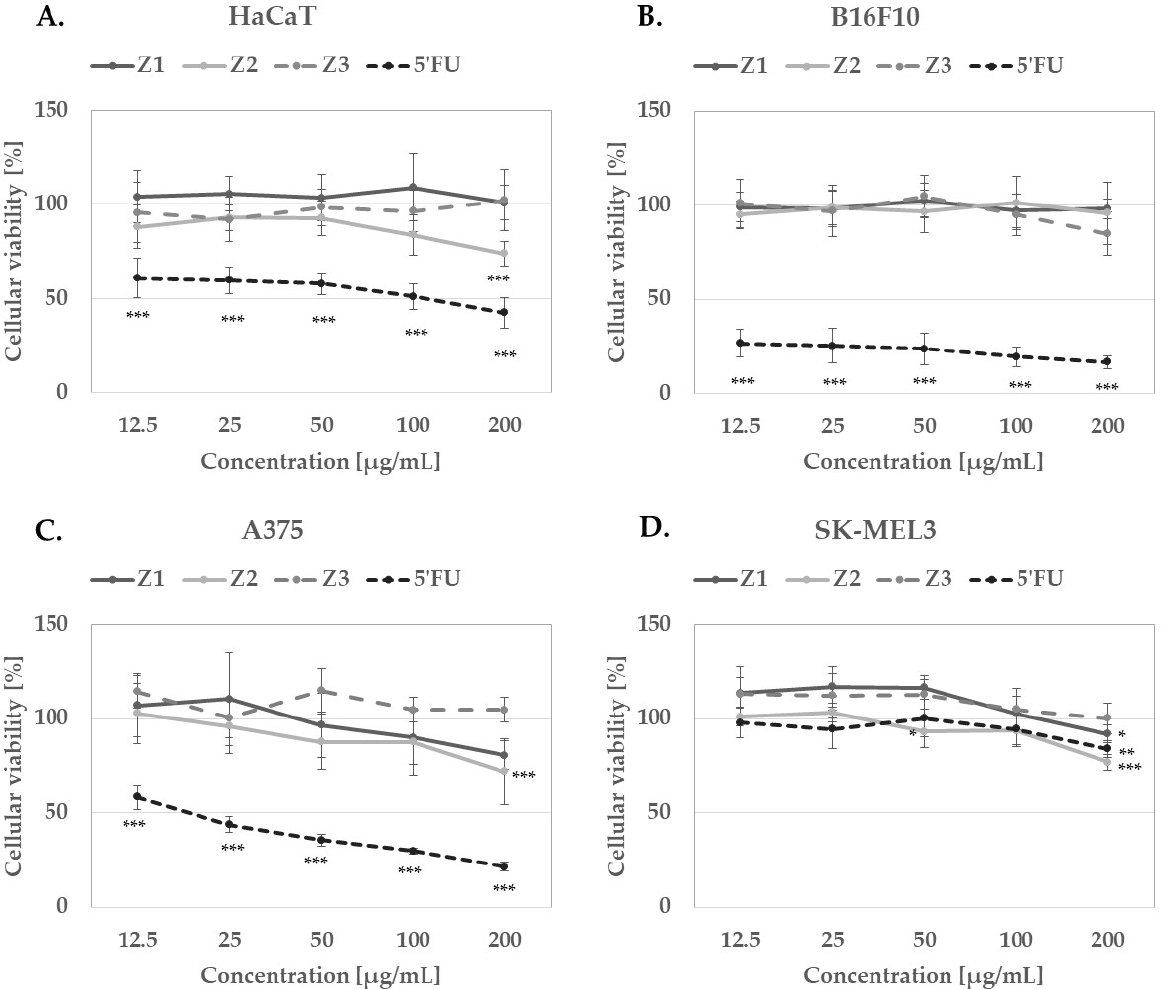
Figure 6. In vitro cytotoxicity of Z1, Z2 and Z3 Z. bungeana extracts on human keratinocytes HaCaT ( A ), murine melanoma B16F10 ( B ) and human melanoma cell lines A375 ( C ) and SK-MEL3 ( D ) following 48 h culture; graphs show mean viability of the cells ± SD in comparison with appropriate solvent controls; * p < 0.05, ** p < 0.01, *** p < 0.001 .